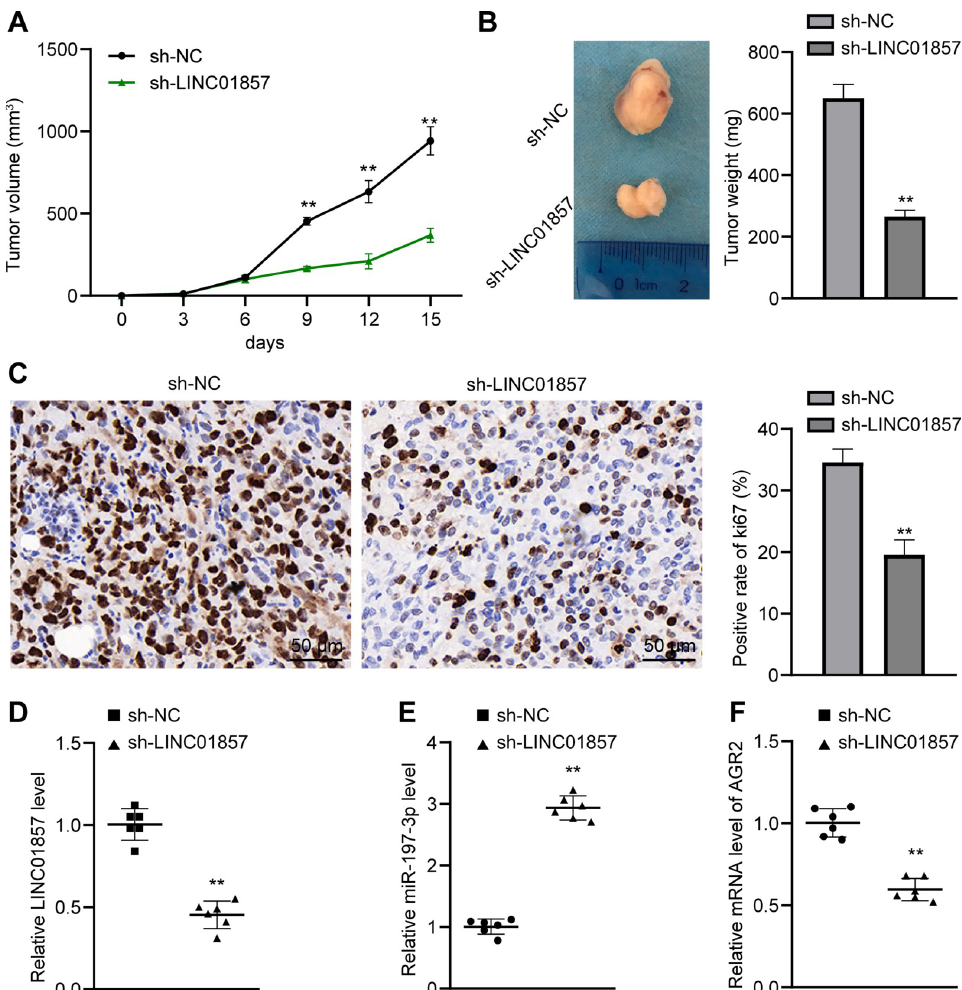
Fig 7. Silencing of LINC01857 inhibits HCC growth in vivo . A, tumor volume in HCC model, n = 12. B, representative images and weights of tumors, n = 6. C, ki67 positive rate of tumors in each group analyzed by immunohistochemistry, n = 6. D, E and F, expression of LINC01857, miR-197-3p and AGR2 mRNA detected by RT-qPCR, n = 6. The results in panels A, B and C were presented as mean ± standard deviation. The independent t-test was employed to analyze the data in panels B, C, D, E and F. Two-way ANOVA was employed to analyze the data in panel A. Tukey’s multiple comparisons test was applied for the post hoc test. Compared with the si-NC group, �� p < 0.01. [41]. When apoptosis was reduced in gastric cancer by overexpressed oncogenes, miR-197-3p was also decreased, illustrating the positive correlation between miR-197-3p and apoptosis [42]. Furthermore, AGR2 overexpression reversed the effect of silencing LINC01857 on reduc- ing HCC cell proliferation and improving apoptosis. Notably, when AGR2 was upregulated by the competitive binding between LINC00460 and miR-342-3p, HCC expansion, aggres- siveness and invasiveness were all enhanced [21]. AGR2 represses apoptosis in cancers, includ- ing pancreatic cancer, cervical cancer and breast cancer [43–45]. Significantly, LINC01857 activated the AKT and ERK pathways by mediating the miR-197-3p/AGR2 axis with the involvement of a high Ki67 protein positive rate. Lim et al . revealed that AKT and ERK knock- down brought about suppression of HCC vitality, aggressiveness and EMT [25]. The levels of AGR2, AKT, ERK and Ki67 were all decreased in pancreatic cancer with downregulated